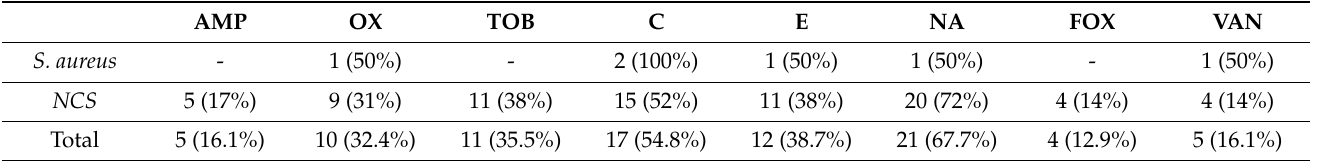
Figure 1. Percentage of bacterial species isolated from catheter tip samples. Table 3. Resistance to antibiotics in strains of Gram-positive